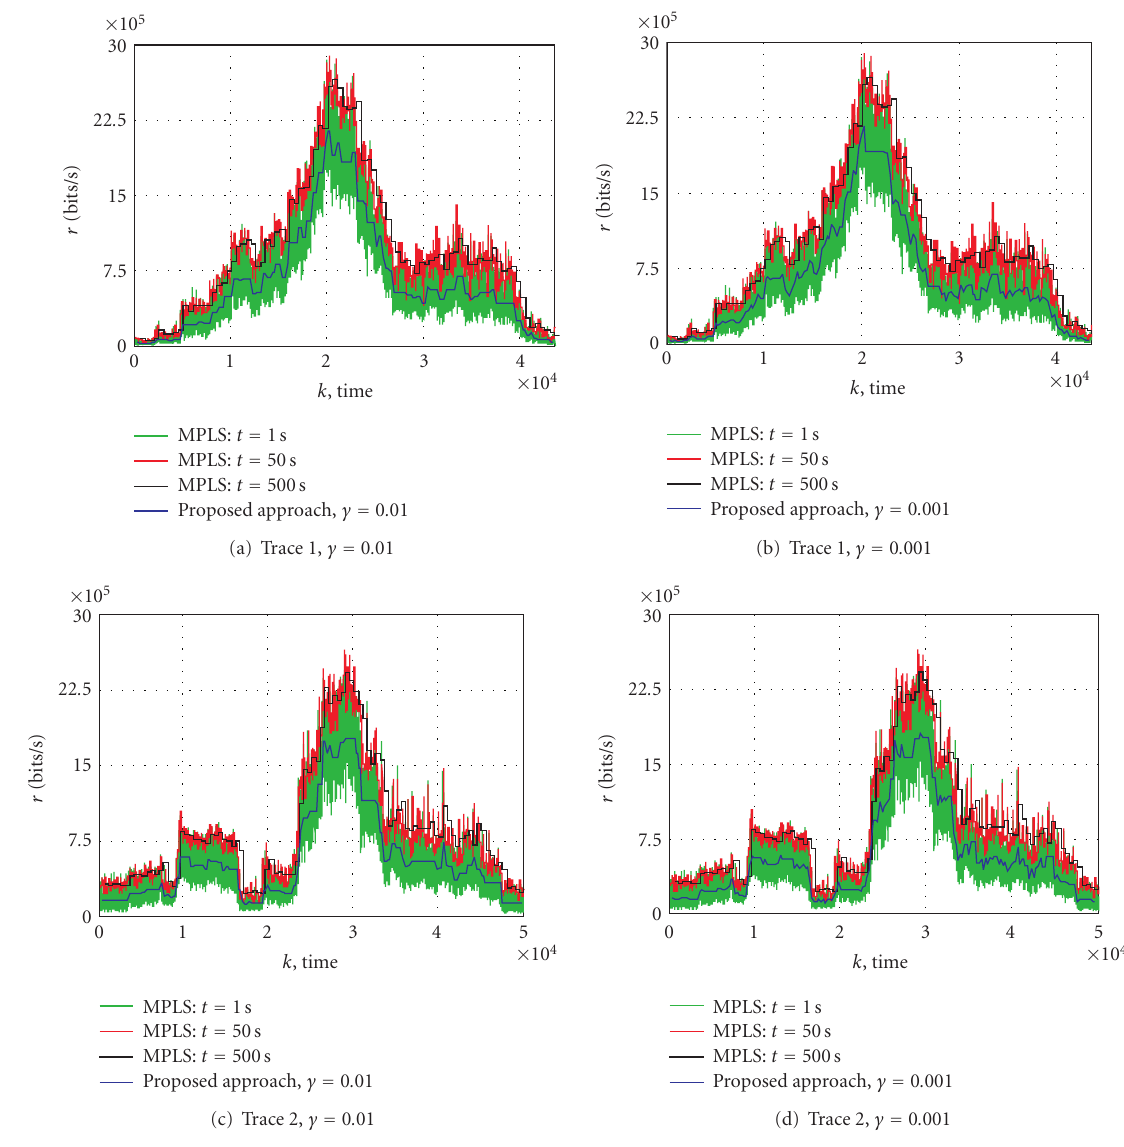
Figure 14: Bandwidth allocations according to di ff erent